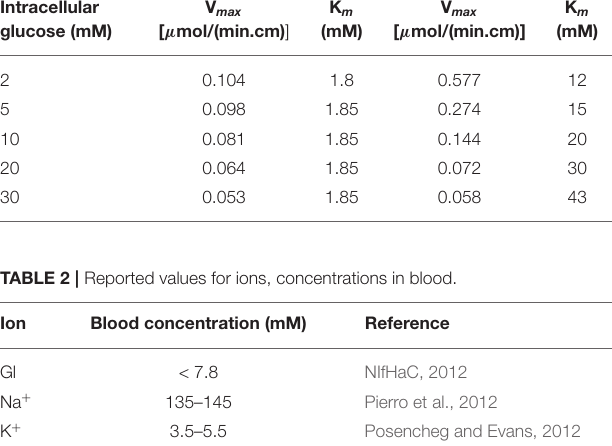
TABLE 1 | V max and K m values for SGLT1 and GLUT2 determined by fitting to the flux values in Figure 2 . SGLT1